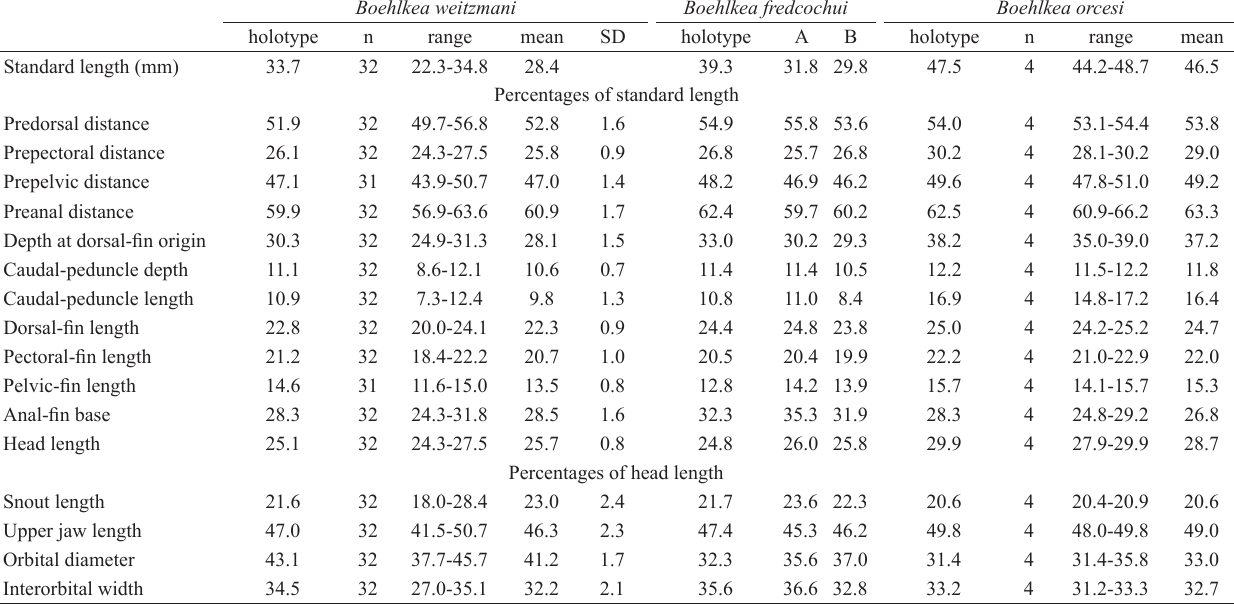
Tab. 1. Morphometric data of the holotype and paratypes of Boehlkea weitzmani (INPA 53202), B. fredcochui (holotype ANSP 111675, and paratypes ANSP 111668 (A) and 111676 (B)), and B. orcesi (holotype USNM 164064, and paratypes ANSP 75904, USNM 175128). Range includes the holotype. SD= Standard